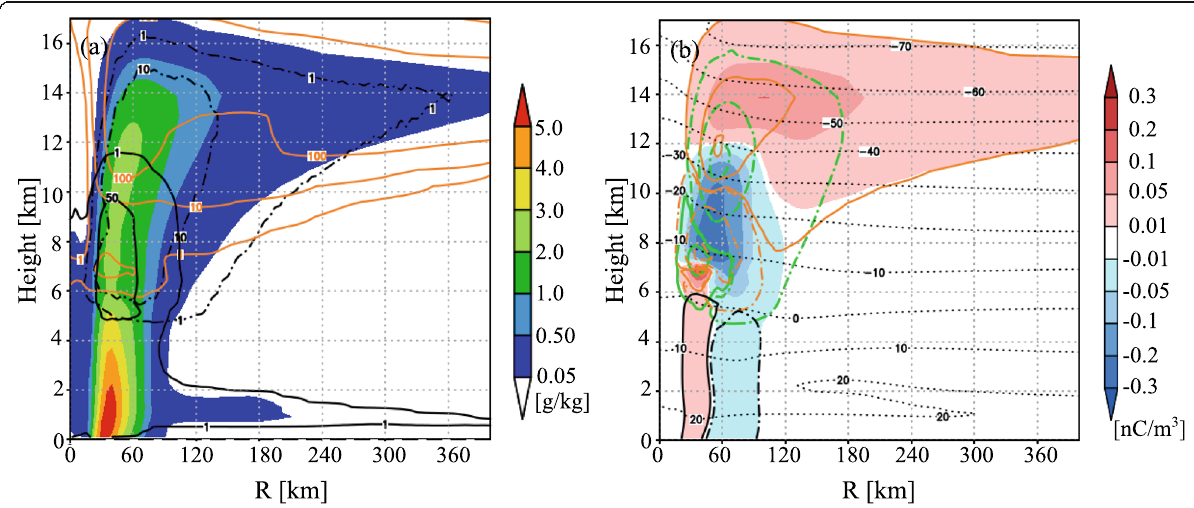
Fig. 4 Number concentration of a sum of cloud water and rain water (black solid contour line), sum of ice and snow (orange contour line), graupel (black dot-dashed contour line), and total hydrometeor q hyd (shaded area); and b charge density of graupel (green contour line), sum of ice and snow (orange line), and cloud and rain (black contour line), and the total charge density over the z – R plane (shaded area). The variables were tangentially averaged during the last 12 h of the simulation. Solid and dash-dotted contours in b show positive and negative charge densities, respectively, and contour lines in a and b show 0.05, 1, 3, and 5 g kg − 1 and 0.01, 0.1, and 0.3 nC m − 3 , respectively. The dotted line in b indicates temperature (°C)